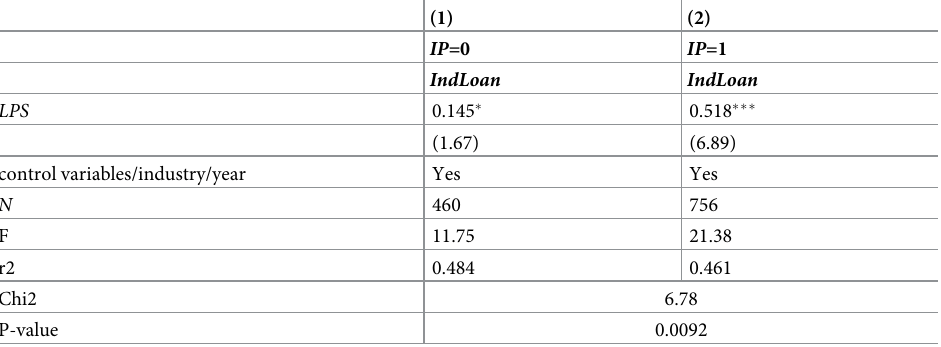
Table 8. Large private shareholders and industrial loans of city commercial banks (Difference between groups).